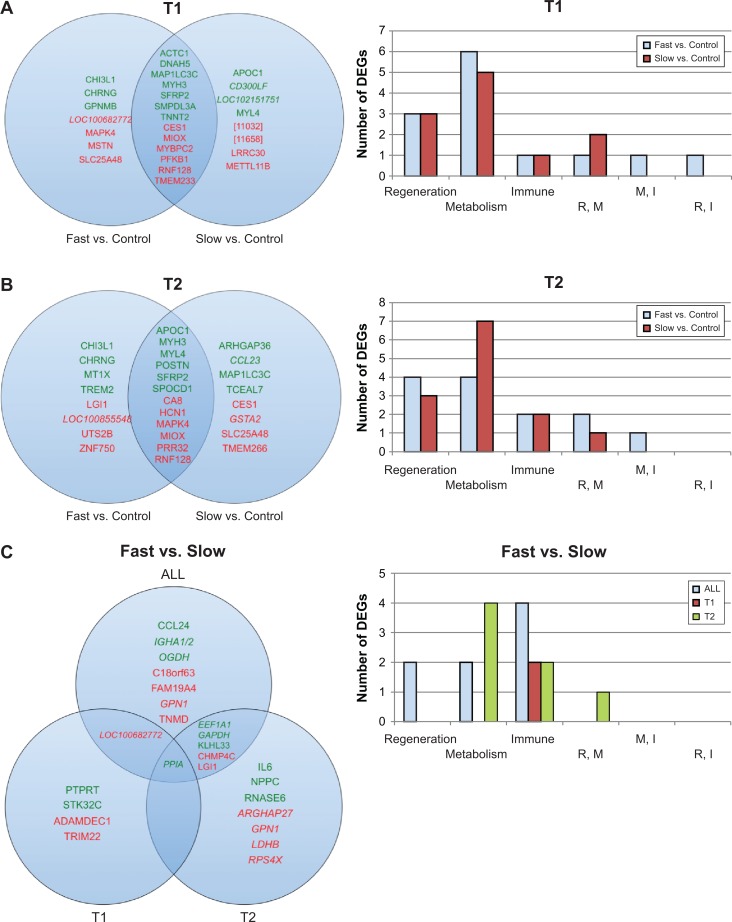
Top 10 DEGs for A) T1: age 3 months, GRMD vs. control; B) T2: age 6 months, GRMD vs. control; C) fast vs. slow progressing GRMD dogs. Green font indicates up-regulated genes; those genes in red font were down-regulated. Venn diagrams on the left of each panel include names of Top 10 DEGs; graphs on the right of each panel indicate numbers of DEGs with functions related to regeneration, metabolism, immune response, both regeneration and metabolism (R,M), both metabolism and immune response (M,I), or both regeneration and immune response (R,I).